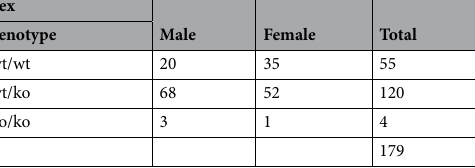
Absence of GGNBP2 results in infertility in mice. using PCR. Two clones were positive, and both clones carried the 5 ′ arm and the 3 ′ arm (Fig. 1). The targeted ES cells were injected into 87 blastocysts and then implanted into 6 uteri of female mice for development. Seven chimeric male mice were generated and backcrossed into C57BL/6 background female mice. Eight heterozygous offspring were verified using the method described above. Heterozygous offspring were interbred, and 179 pups of twenty breedings were used to analyze the phenotypes of three different genotypes; wt/wt, wt/ko and ko/ko (Table 1). Fifty-five animals had the wt/wt genotype and 120 had the wt/ko genotype. The number of ko/ko mice was 4 (3 males and 1 female), which was much less than expected. There was no obvious difference in the weight or activities between the genotypes, except that all male KO mice were infertile. Absence of GGNBP2 results in abnormal testis morphology. tological analysis. The only identified abnormality was found in the testes of male homozygous mice (ko/ko), in which the morphology of the convoluted seminiferous tubules was visibly altered. A histological analysis of the epithelium of the convoluted seminiferous tubules revealed that these appeared lower and more loosely struc- tured than in the wild-type and heterozygous siblings (Fig. 2A). There was no significant difference in the num- ber of sperm between the wild-type and heterozygous mice. However, nearly no sperm cells could be observed inside the seminiferous tubules of homozygous KO mice. The number of sperm in wild-type, heterozygous and of view at 400x magnification), respectively. The P values of ko/ko to wt/wt and of ko/ko to wt/ko were less than 0.001, and the P value of wt/wt to wt/ko was 0.648 (Fig. 2B). Absence of GGNBP2 increases apoptosis in the testis. of GGNBP2 KO mice. The apoptotic cells in wild-type mice and heterozygous mice were located near the base- ment membrane. In contrast, apoptotic cells in the testes of GGNBP2 KO mice were more dispersed towards the